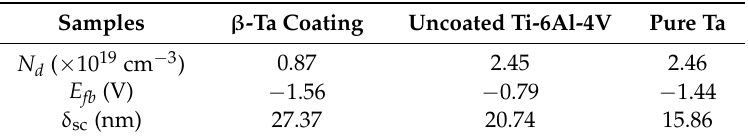
Table 3. Semiconducting parameters derived from the Mott-Schottky analysis for the passive films formed on the investigated specimens in Hank’s solution at 37 ◦